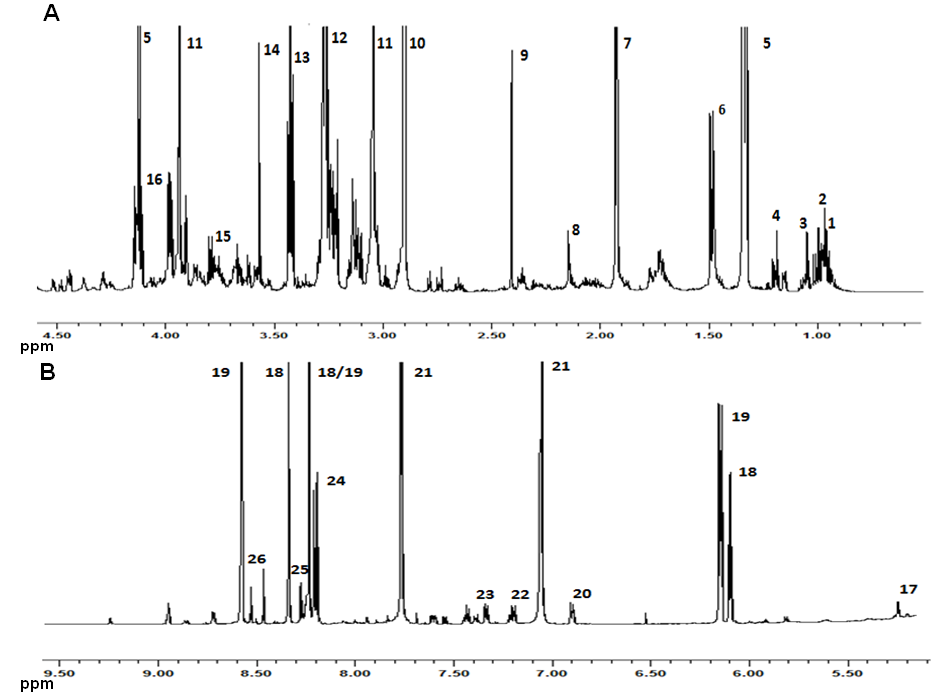
Figure 1. 600.13 MHz 1 H NMR spectrum of TCA Bogue fish extract. The numbers refer to the assignments reported in Table